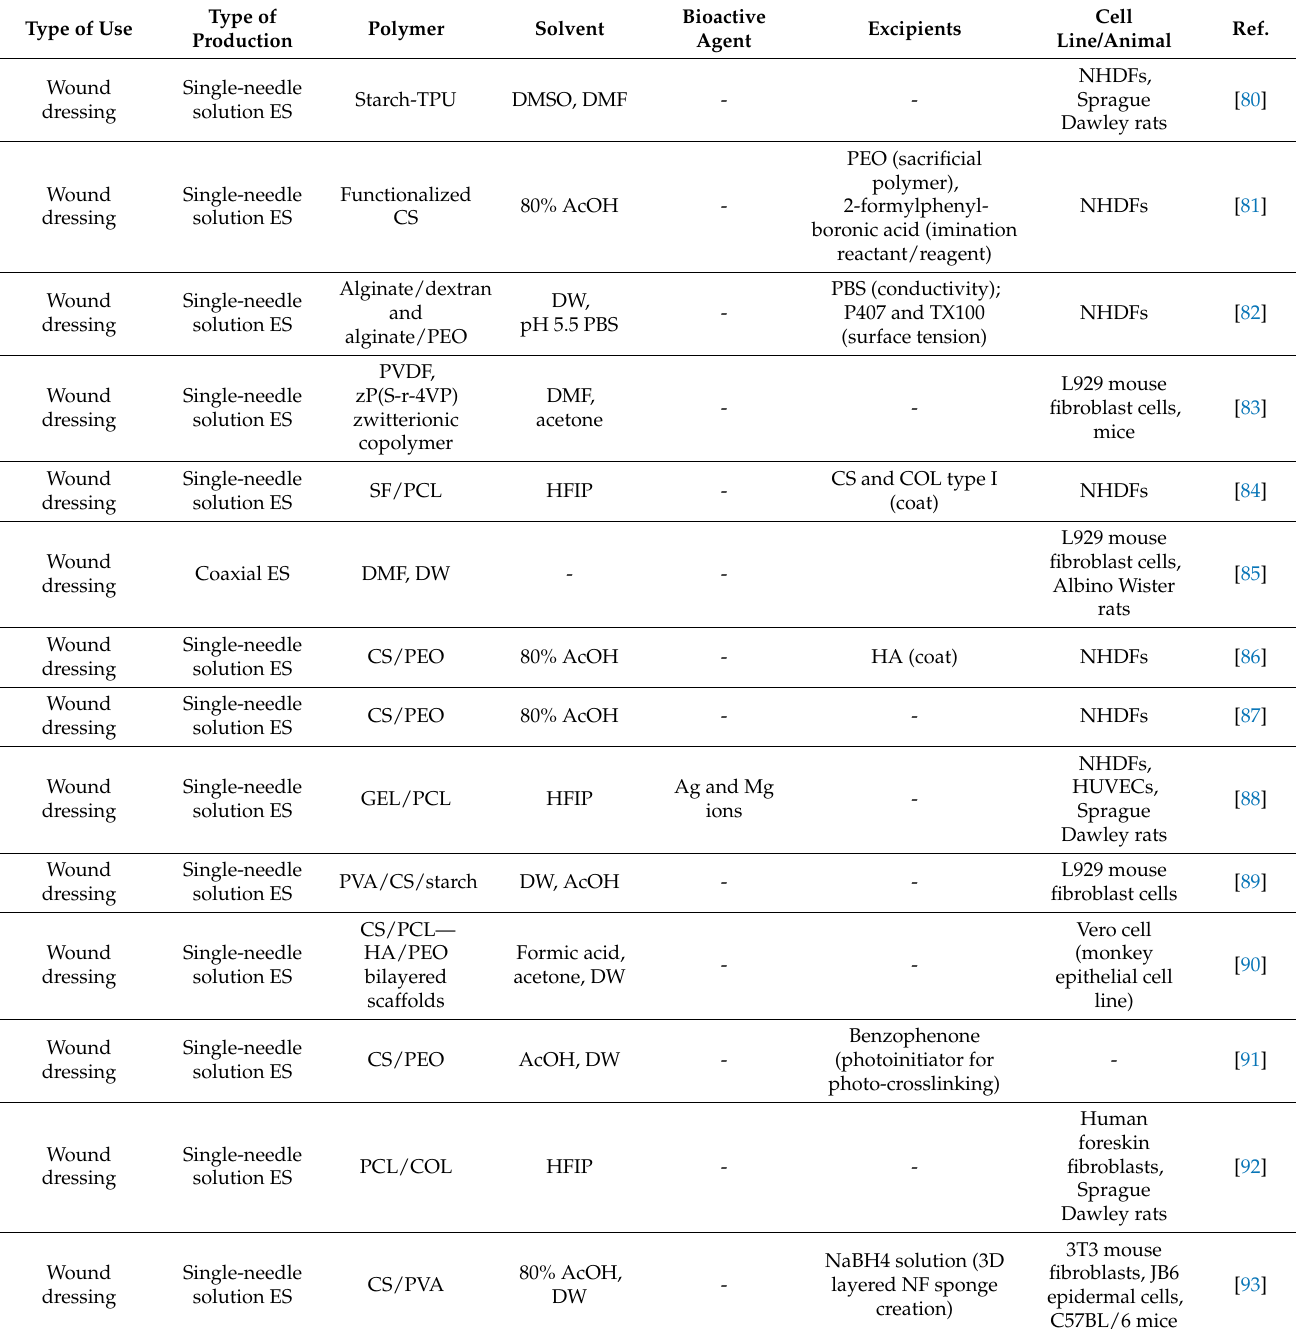
Table 1. Recent studies on electrospun nanofibers as potential medical